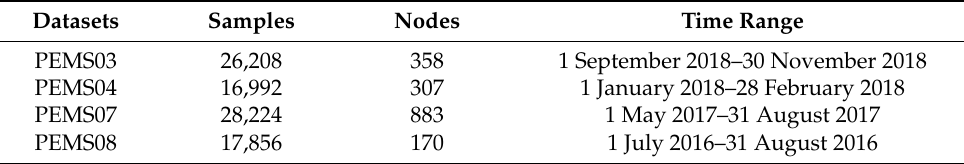
Table 1. Dataset